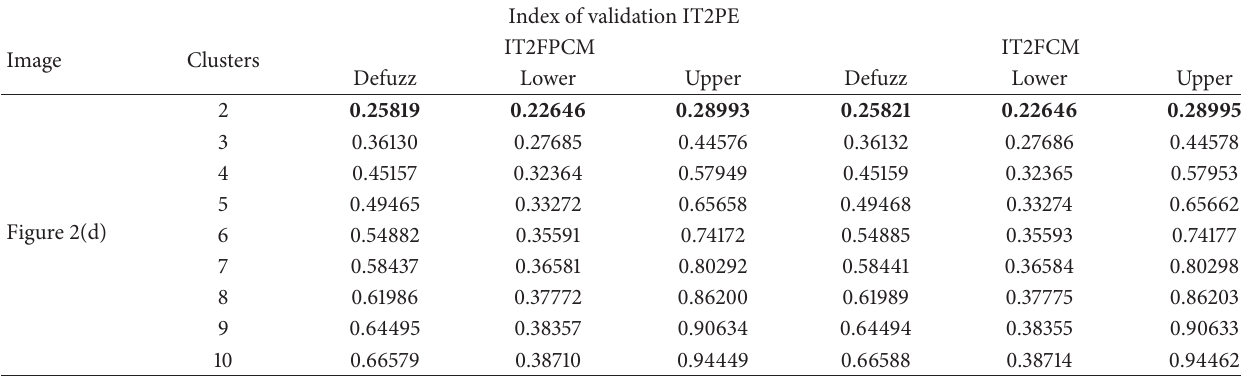
Table 38: Results of the IT2PE validation index to the clustering of image shown in Figure 2(d) using IT2FPCM and IT2FCM algorithm with 𝑚 = [1.5, 2.5] and 𝜂 = [1.5, 2.5] as parameters.